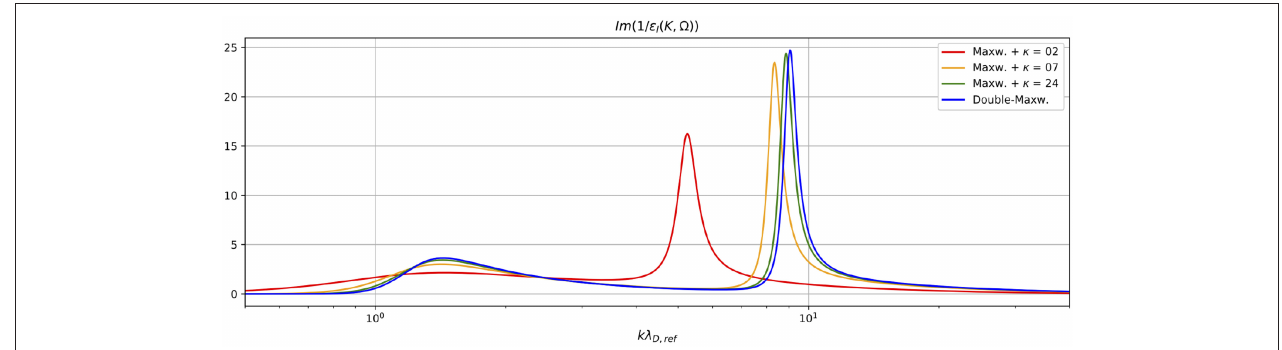
FIGURE 2 | Im (1 /ε l ( K , (cid:127) )) for (cid:127) 1.10 in a plasma modeled by a mix of a core Maxwellian evdf and a halo kappa evdf for several κ -values ( κ = 2, 7, 24) and a double = Maxwellian evdf, where the modified Langmuir mode and the electron acoustic mode co-exists (here: n h / n c = 1 and T h / T c = 100). λ D , Ref is the Debye length of the halo Maxwellian evdf.